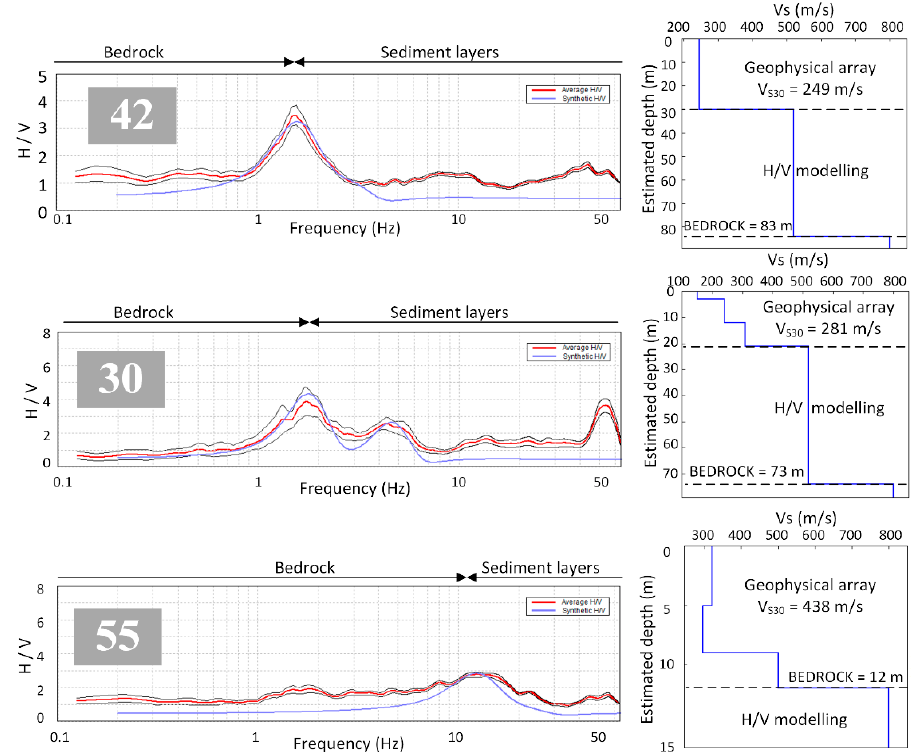
Figure 8. Examples of H / V forward modelling routine: Left : Observed H / V spectra (red) fitted with theoretical HVSR curve for representative soil model shown in right figures. Right : Values of V S30 estimated from geophysical data and H / V forward modelling.